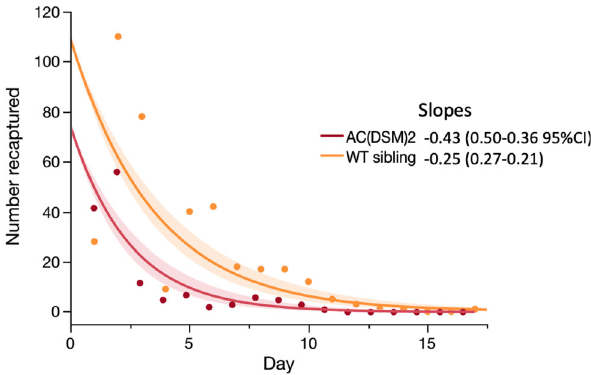
Fig. 3 Decrease in recaptures of sterile Ac(DSM)2 males and their WT siblings. The rate of recaptures (slope) decreased signi fi cantly faster in Ac(DSM)2 ( − 0.43 (0.50 – 0.36 95%CI) than in siblings ( – 0.25 (0.27 – 0.21). (Ac(DSM)2: Anopheles coluzzii Dominant Sterile Male; WT sibling: Wild type sibling).